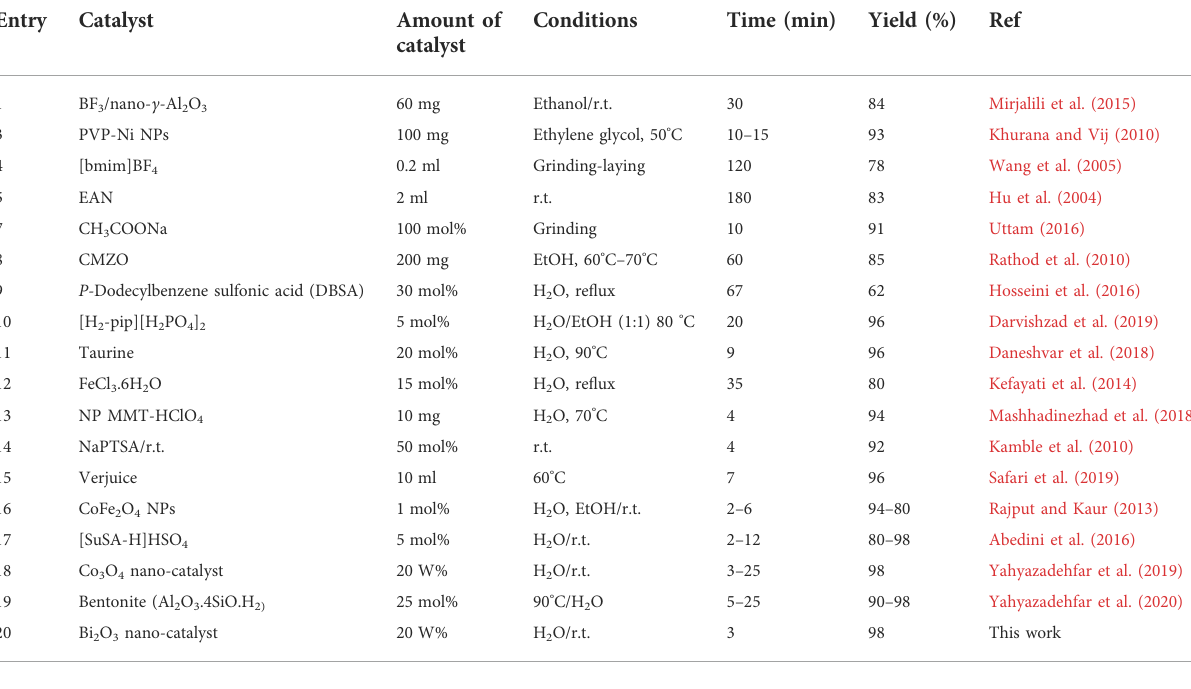
TABLE 4 Comparison of various methods for the synthesis of (thio)barbituric